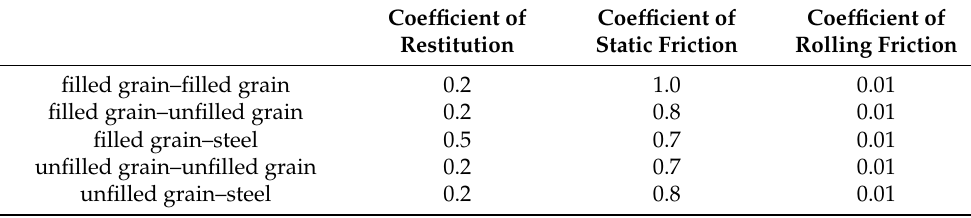
Table 2. Contact coefficient of